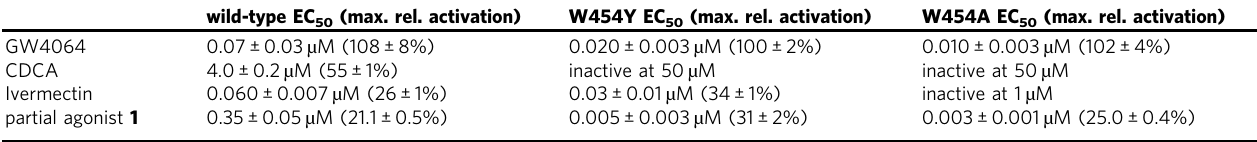
Table 1 Activities of FXR agonists and partial agonists on wild-type FXR and mutants W454Y and W454A wild-type EC 50 (max. rel.